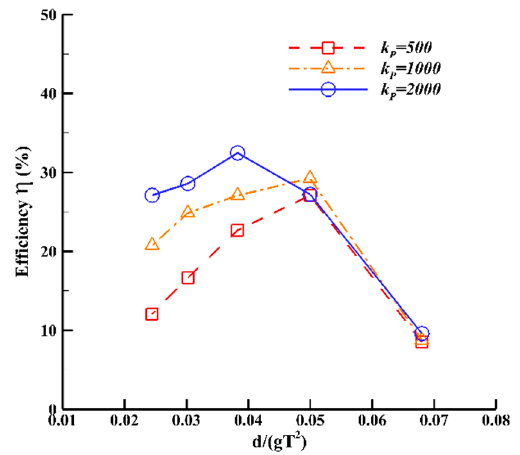
Figure 22. Effects of PTO coefficient on wave power absorption efficiency ( H = 0.1 m). Figure 22. E ff ects of PTO coe ffi cient on wave power absorption e ffi ciency ( H = 0.1